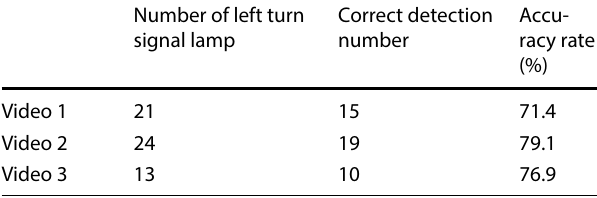
Table 5 Left turn signal lamp (left signal lamp on and right signal lamp off) detection